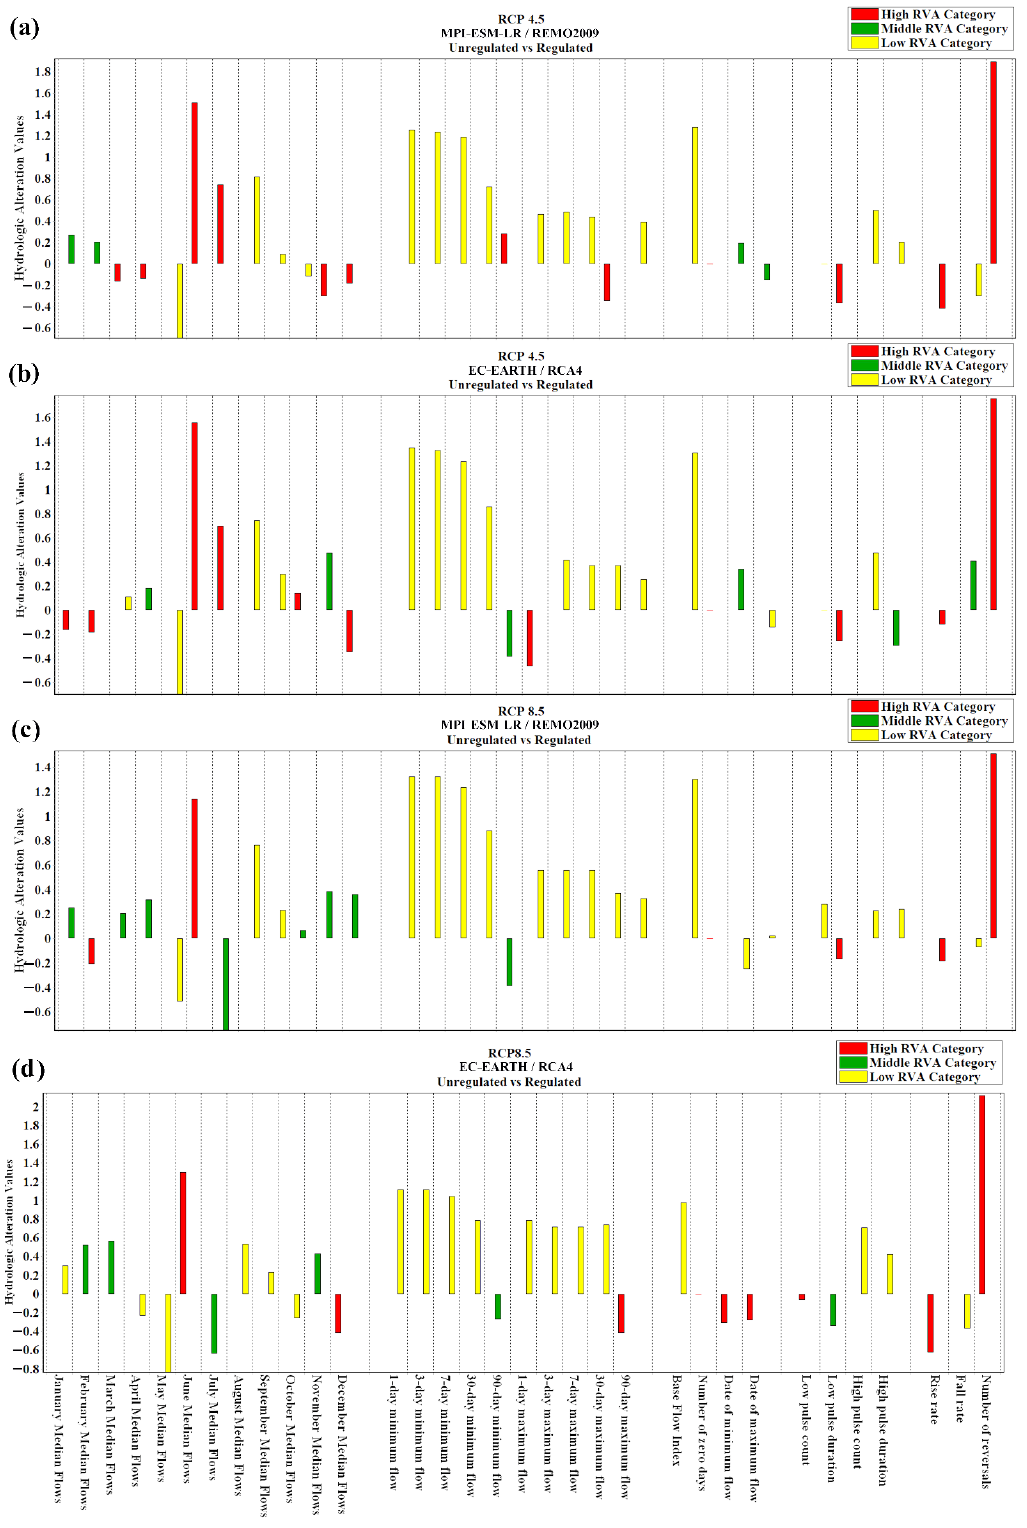
Figure 9. Unregulated conditions as pre − hydrologic alteration and regulated conditions as post − hydrologic alteration for ( a ) RCP 4.5/MPI − ESM − LR/REMO2009, ( b ) RCP4.5/EC − EARTH/RCA4, ( c ) RCP 8.5/MPI − ESM − LR/REMO2009, ( d ) RCP4.5/EC −